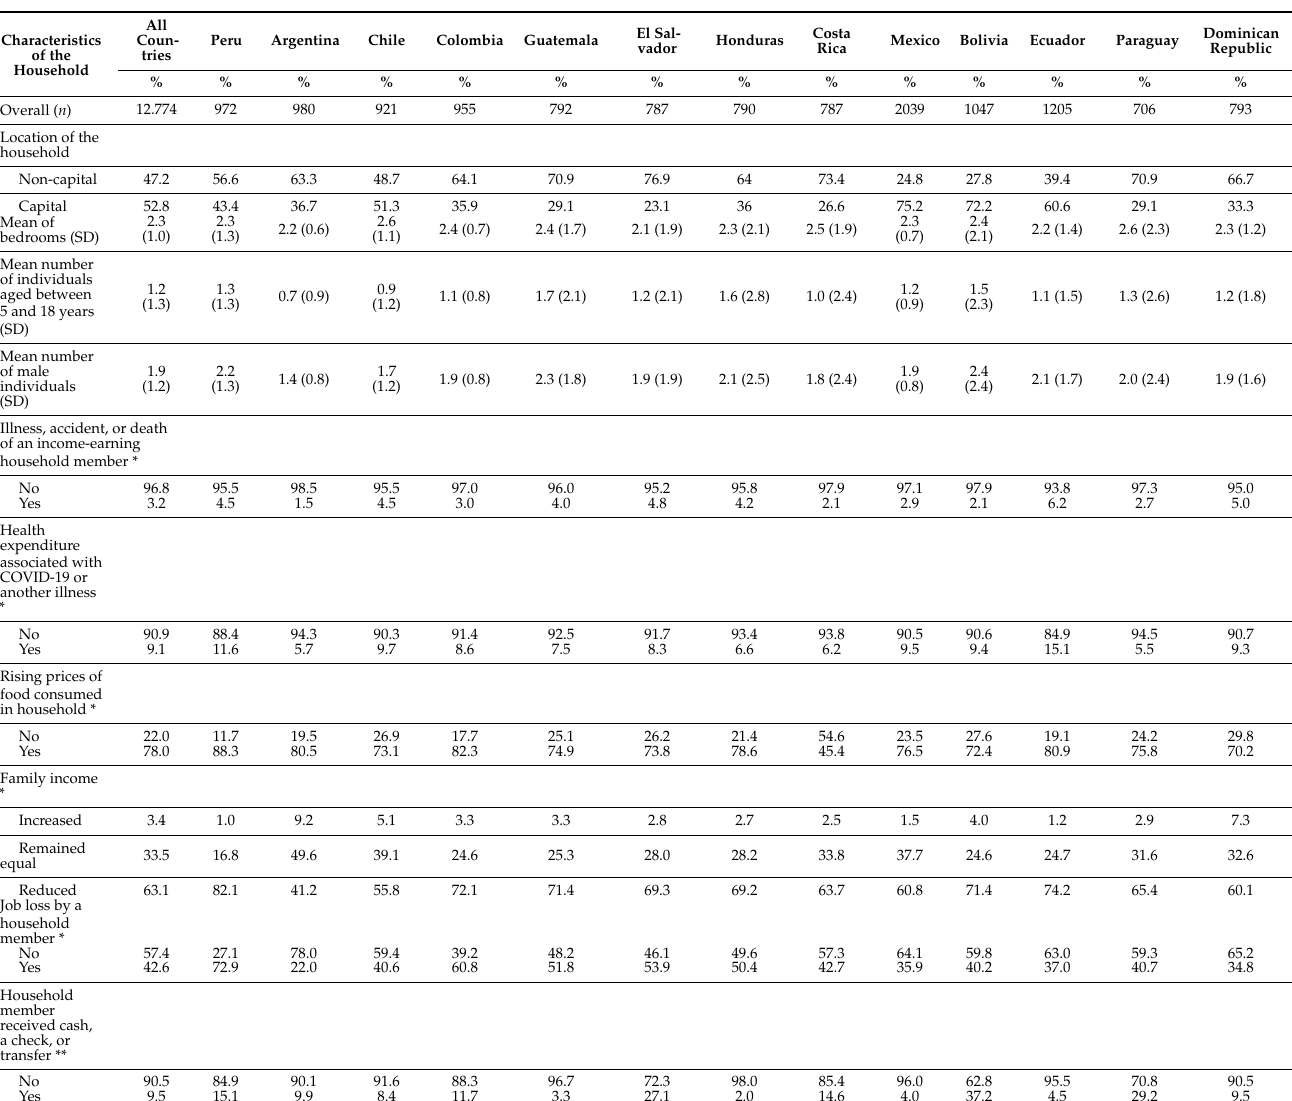
Table 1. Characteristics of the households included in the analysis by